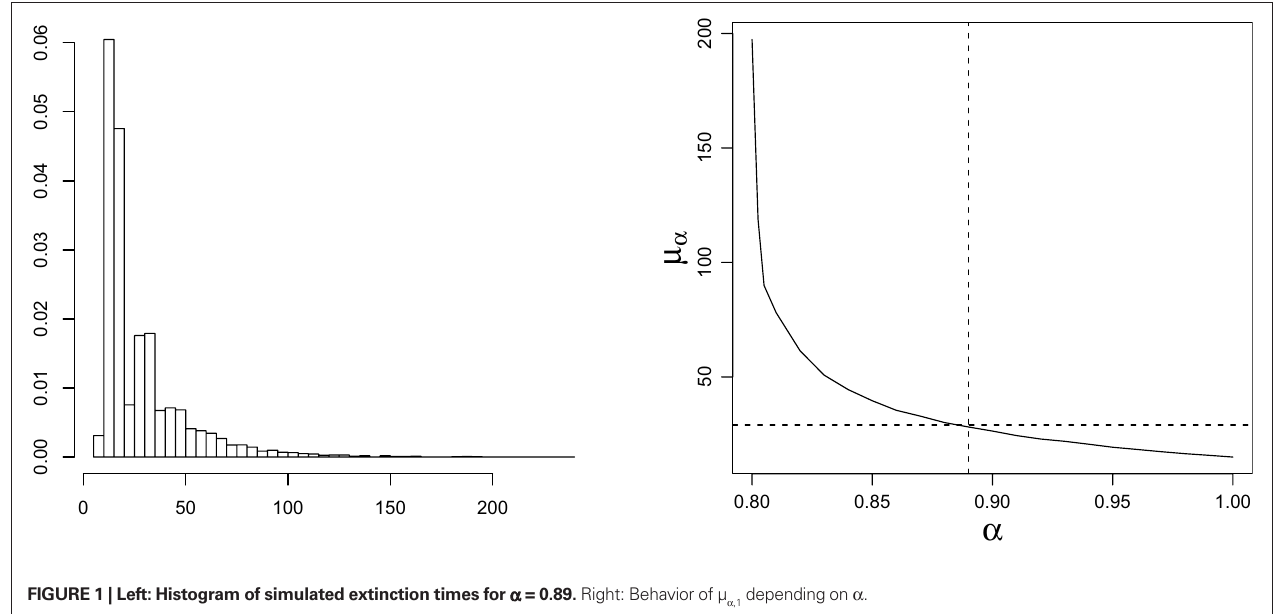
depending on α . α ,1